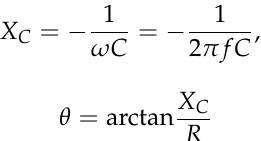
Figure 3. Use of the double-shell electrical model. 𝑅 (cid:2869) represents the cell wall resistance and the ECF , 𝑅 (cid:2870) represents the cytoplasmic resistance, 𝐶 (cid:2871) represents the cell membrane capacitance, 𝑅 (cid:2872) represents the vacuole resistance, and 𝐶 (cid:2873) represents the vacuolar membrane capacitance. When excited by an alternating electric current, tissue shows a frequency-dependent behavior: at low frequencies, cell membranes act as insulating barriers with resistive path- ways. Therefore, the size of 𝑋 (cid:3004) increases when a low-frequency alternating current is pro- vided to the cell, which results in the low-energy current being unable to pass through the cell membrane. A low or no current can pass through the capacitive reactance ( 𝑋 (cid:3004) ), which corresponds to the cell membrane and the applied signal’s frequency. However, as the frequency of the applied alternating current increases, 𝑋 (cid:3004) gradually decreases, and the current flows through the cell membrane into the cell. At high frequencies, currents can penetrate cell membranes due to their high capacitance, and a large amount of the current can flow through both the ICF and ECF (Figure 4). At both low and high frequencies, the path of the conduction current through biological tissues is shown in Figure 4.